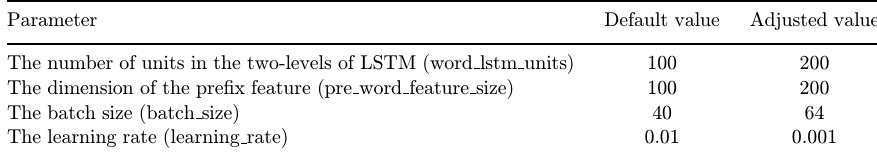
Table 1. Adjusted values of key